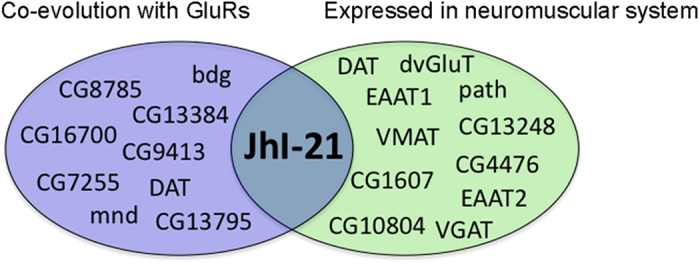
Candidate amino acid transporters involved in glutamatergic transmission.The Drosophila genome encodes 39 genes showing homology to amino acid transporters444. 10 of those were predicted to be co-evolving with GluRs by usage of ERC (blue) (ERC-values >0.23 and p < 0.05). Out of those 39 putative transporter genes 11 show the highest level of expression in the same tissue as either mGluRA (highest expression in the CNS) or iGluRs (highest expression in the body wall) (green). We picked one candidate gene, JhI-21, for further analysis.